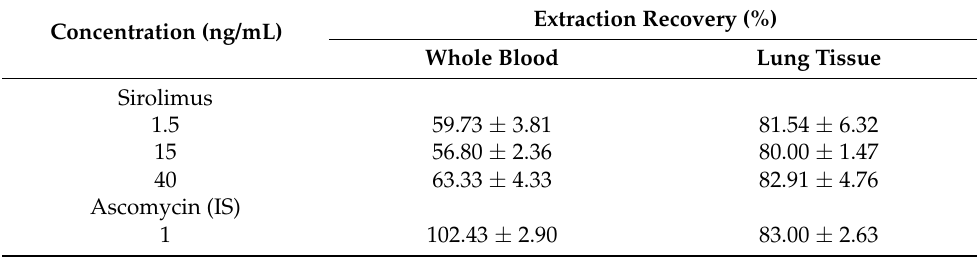
Table 3. Extraction recovery of sirolimus and IS in porcine whole blood and lung tissue samples.